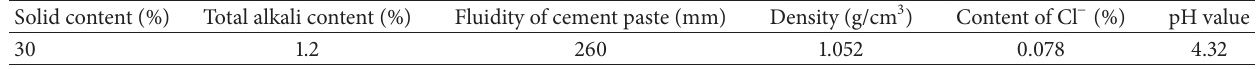
Table 4: Properties of high range water reducing agent.